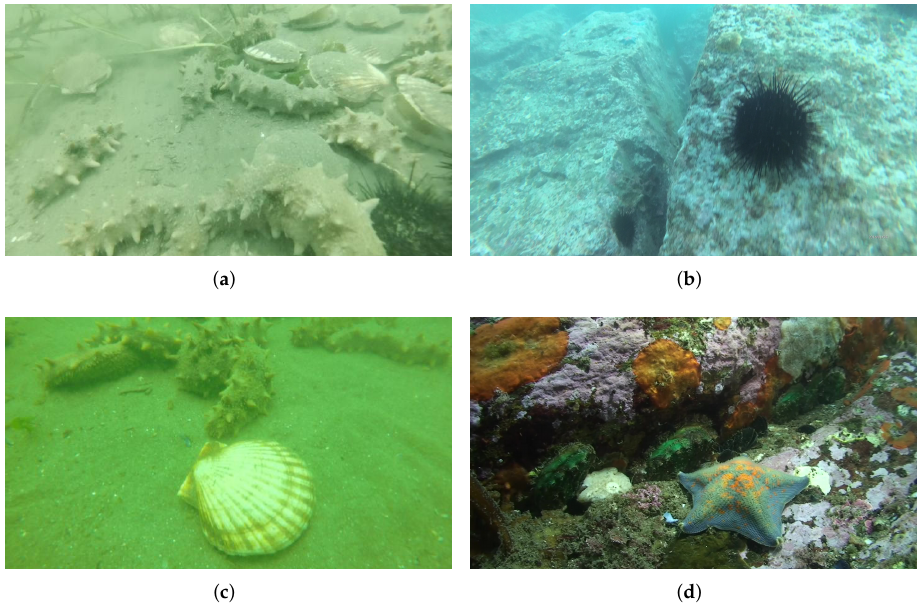
Figure 8. The dataset contains four biological categories, which are ( a ) holothurian, ( b ) echinus, ( c ) scallop, and ( d ) starfish.